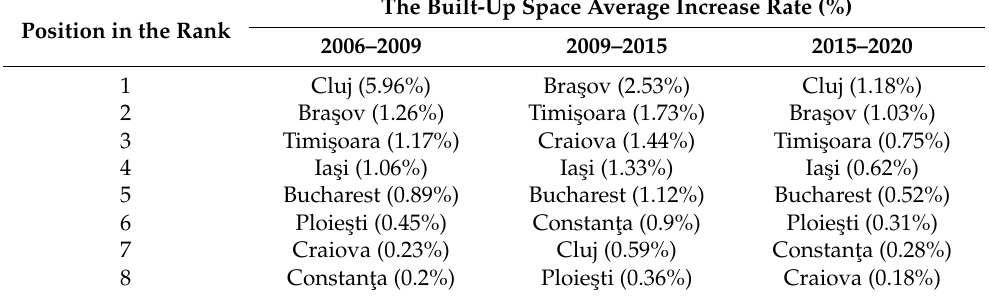
Table A1. The built-up space average increase rate ranking for the three